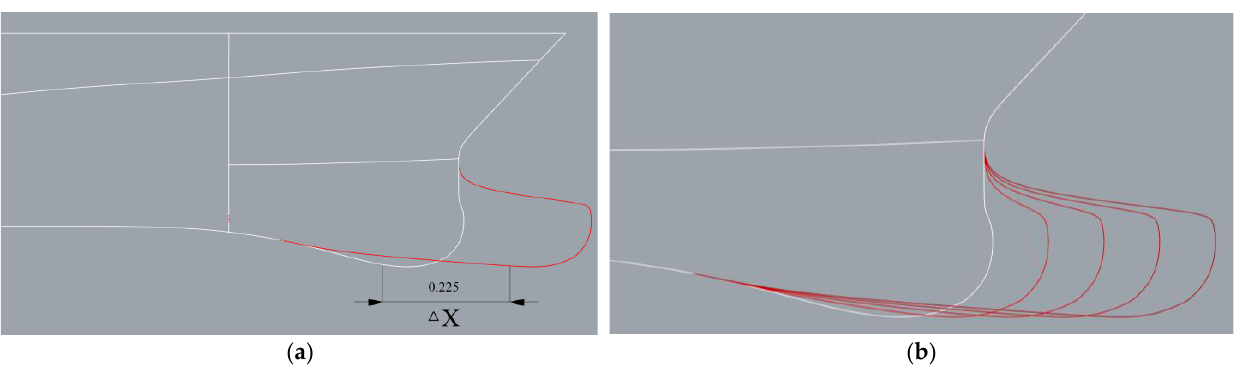
Figure 3. Protruding sonar dome geometry. ( a ) Protruding distance ∆𝑋 of control point; ( b ) sonar dome shape variations. White lines are the geometry of the ship’s hull and original sonar dome. Red lines are the different sonar dome configurations in this study.